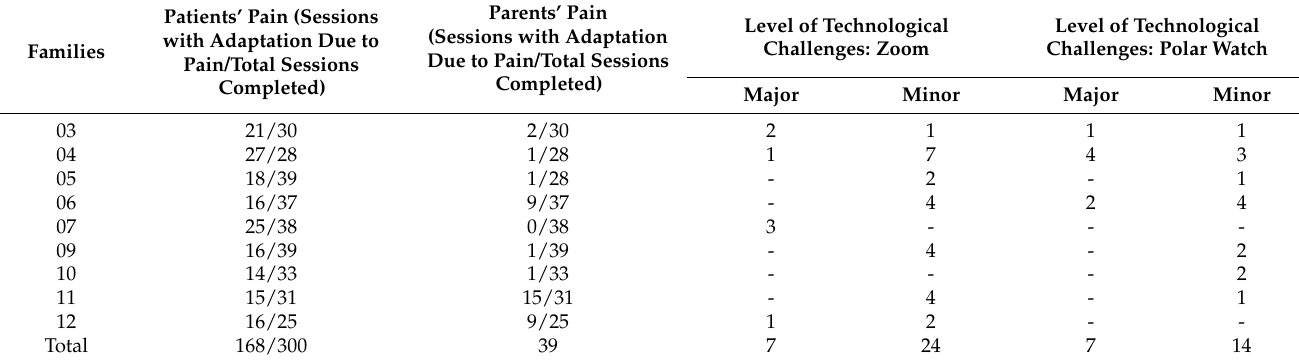
Table 2. Barriers to interventions reported in the kinesiologist’s clinical notes for each family. Patients’ Pain (Sessions with Adaptation Due to Families Pain/Total Sessions